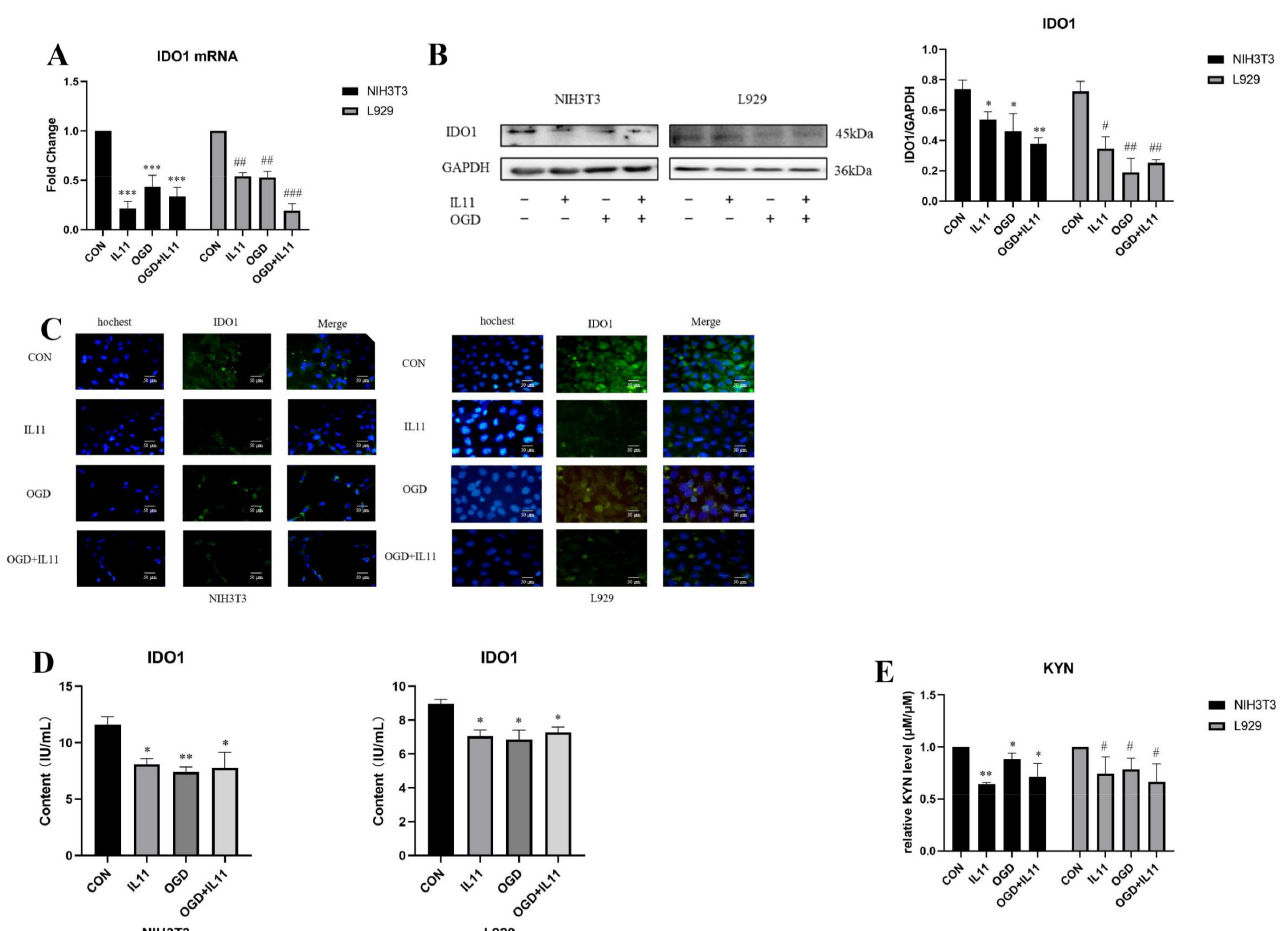
Figure 9. IL11 inhibited the expression of IDO1. ( A ) mRNA expression estimated by RT-PCR for IDO1 after supplementing rmIL11 in NIH3T3 and L929 cells. ( B ) Western blot analysis and densitometric analysis of IDO1 protein levels after supplementing rmIL11 in NIH3T3 and L929 cells; GAPDH was used as the loading control. ( C ) Representative immunocytochemistry staining of IDO1 and cell nuclei (Hoechst) after supplementing rmIL11 in NIH3T3 and L929 cells. ( D ) IDO1 content estimated by ELISA from treated cell lysate. ( E ) The relative KYN level was detected by Ehrlich assay after inhibiting IL11 in NIH3T3 and L929 cells. OGD—oxygen–glucose deprivation; CON—control. The results are presented as the means ± SDs, and Student’s t-test was used to determine the p -value. * p < 0.05, ** p < 0.01, and *** p < 0.001, compared with CON group in NIH3T3 cells; # p < 0.05, ## p < 0.01, and ### p < 0.001 compared with CON group in L929 cells.